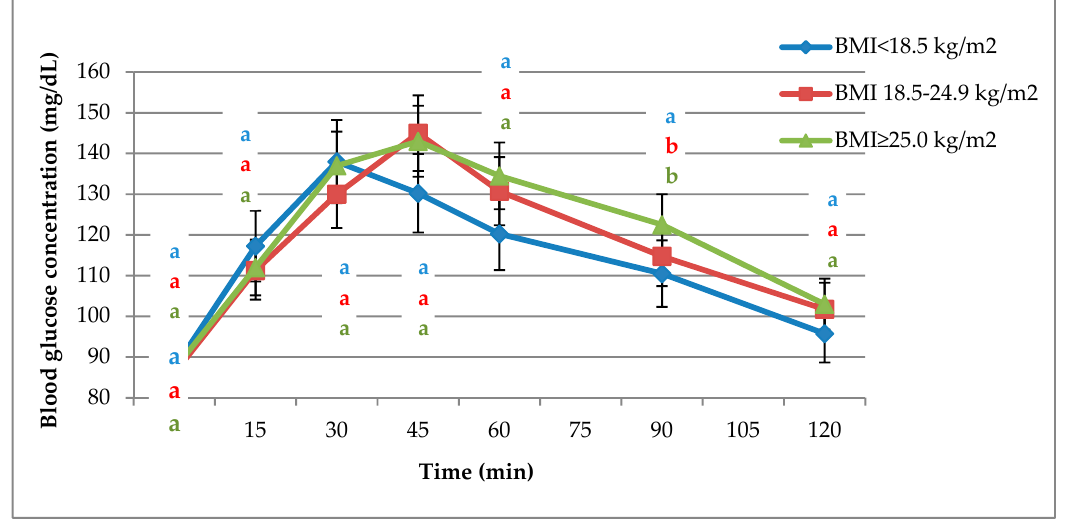
Figure 2. Curves of glycaemic response after consumption of a standard glucose solution. ( a , b ): significantly different at p < 0.05.